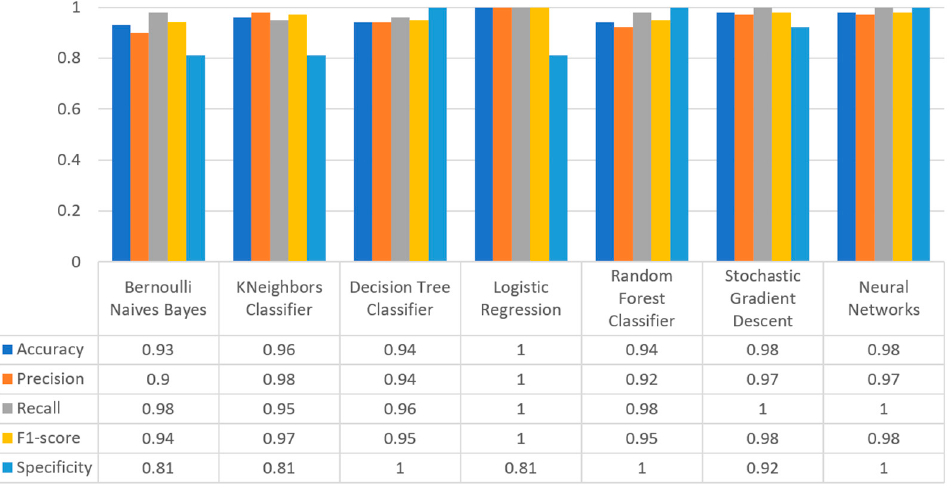
Figure 32. Performance comparison in the kidney disease use case.